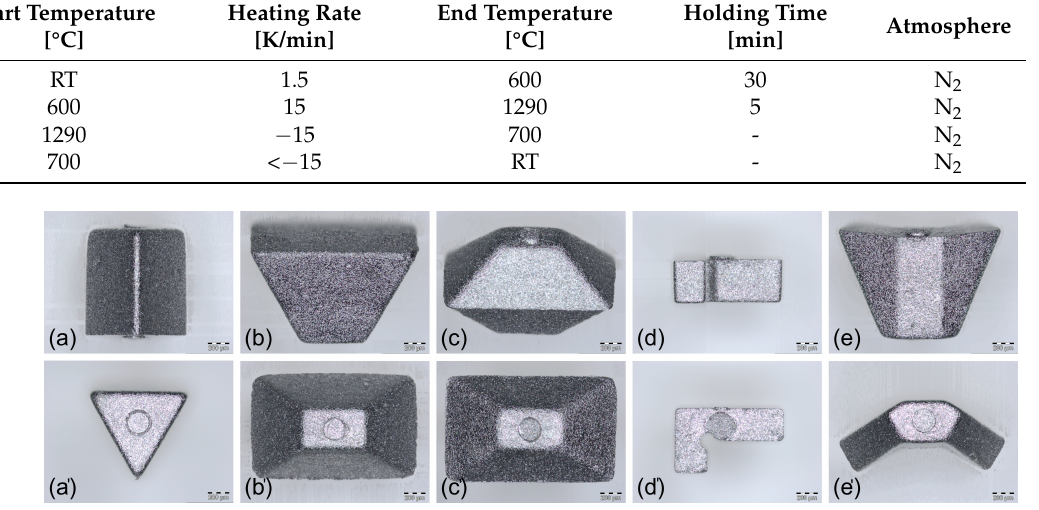
Figure 5. Finally sintered geometrically defined test particles: ( a , a’ ) Triangular prism. ( b , b’ ) Truncated pyramid. ( c , c’ ) Octahedron. ( d , d’ ) L-angle. ( e , e’ ) Abstract